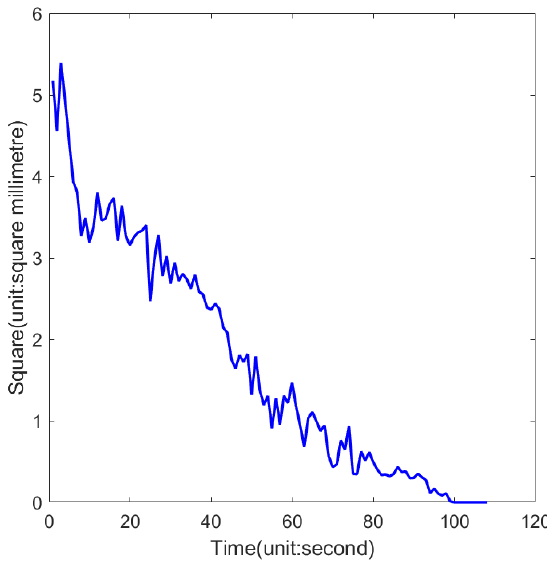
Figure 18. Area change of silicon dioxide at each moment during high-temperature cell melting.